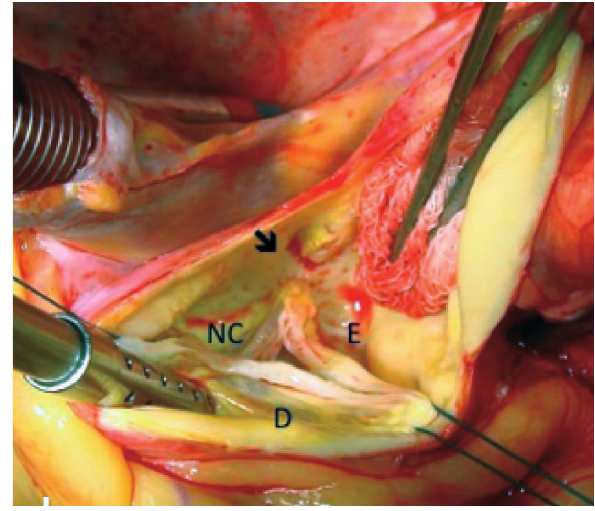
Fig. 1 – Documentação fotográfica do intraoperatório, evidenciando a valva aórtica de aspecto aparentemente normal, porém com avulsão da comissura entre a válvula coronariana esquerda e a não coronariana (seta